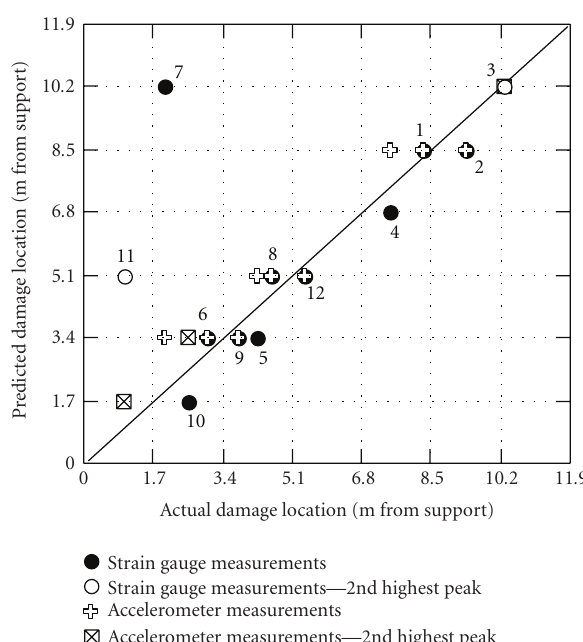
Figure 9: Correlation between predicted and actual damage locations, as calculated by the MSCmethod using strain gauge measured curvatures and those derived from accelerometer data. Numbers refer to experimental damage cases (see Figure